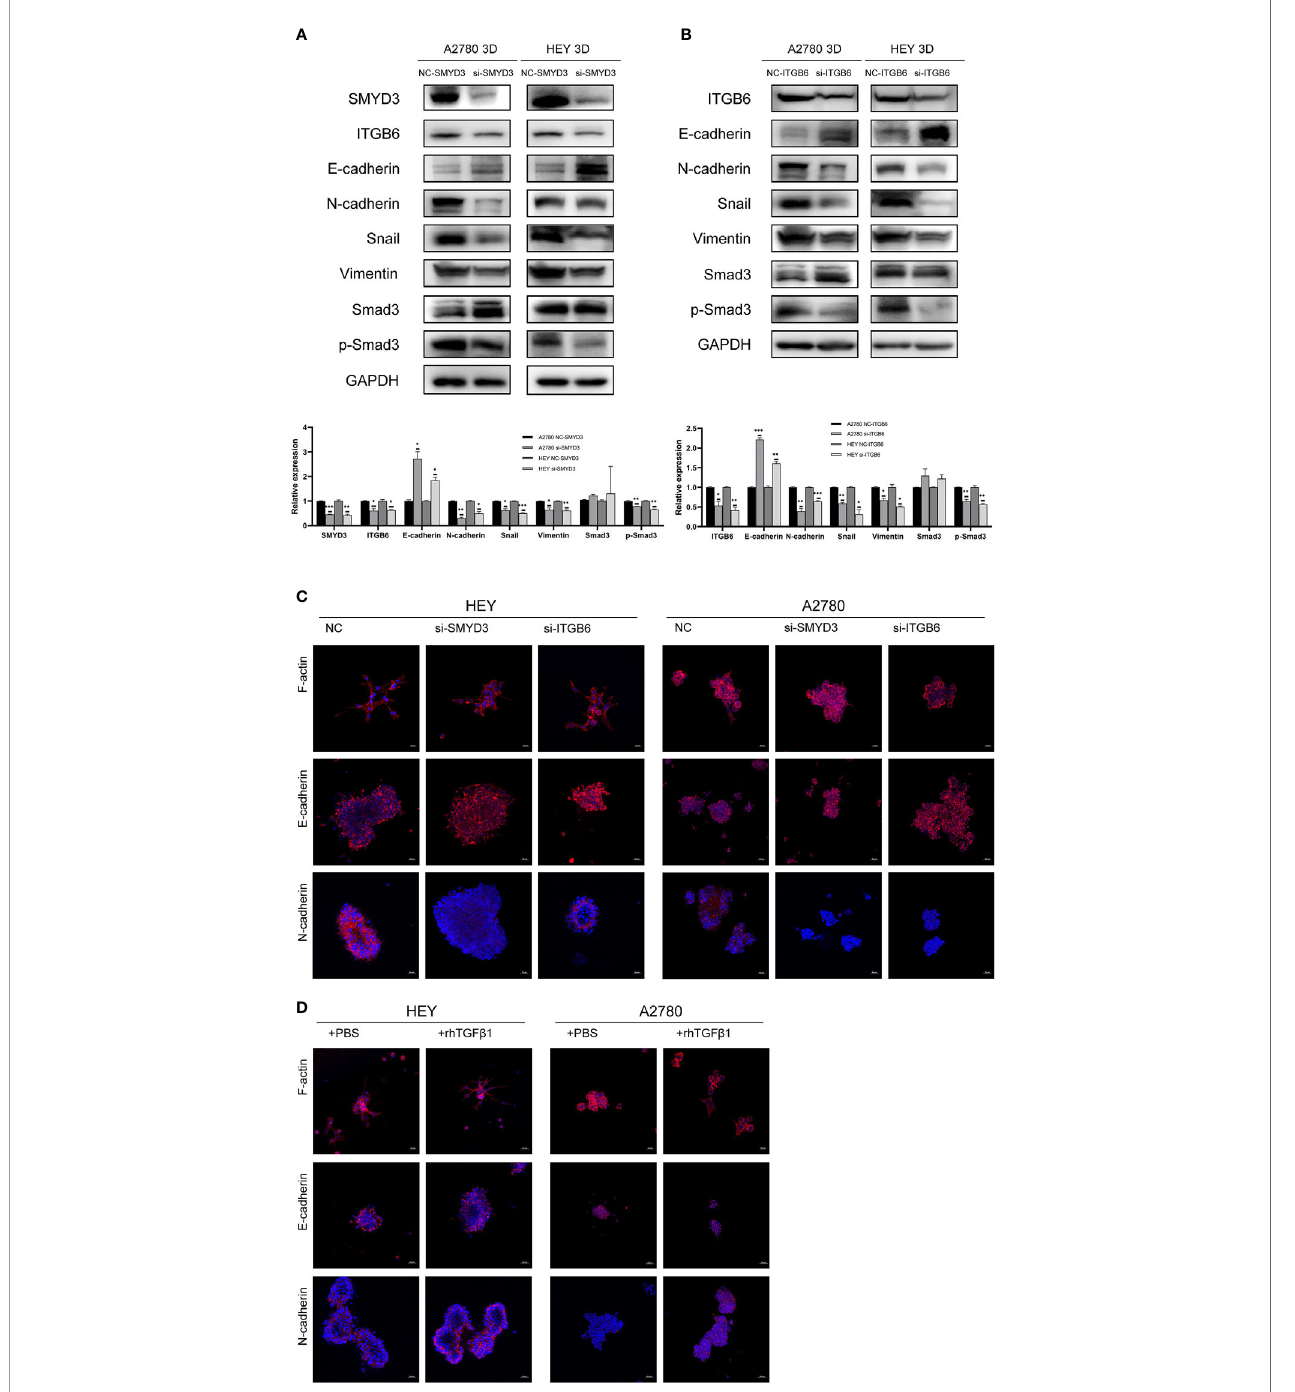
FIGURE 3 | SMYD3 and ITGB6 can activate the TGF b 1/Smad3 pathway and upregulate the expression of EMT-related genes in 3D-cultured ovarian cancer spheroids. (A) The changes in the phosphorylation level of Smad3 and the expression of SMYD3, ITGB6, N-cadherin, Snail, Vimentin and E-cadherin in 3D-cultured HEY and A2780 cells were evaluated by western blot analysis after SMYD3 silencing. (B) The changes in the phosphorylation level of Smad3 and the expression of ITGB6, N-cadherin, Snail, Vimentin and E-cadherin in 3D-cultured HEY and A2780 cells were evaluated by western blot analysis after ITGB6 silencing. (C) Immuno fl uorescence assay exhibited the expression changes of F-actin, E-cadherin and N-cadherin in both 3D-cultured HEY and A2780 cells after silencing SMYD3 and ITGB6, respectively. (D) Immuno fl uorescence assay exhibited the expression changes of F-actin, E-cadherin and N-cadherin in both 3D-cultured HEY and A2780 cells after rhTGF b 1 treatment. In the histogram of the western blot quanti fi cation, “ * ” refers to p < 0.05, “ ** ” refers to p < 0.01, and “ *** ” refers to p <